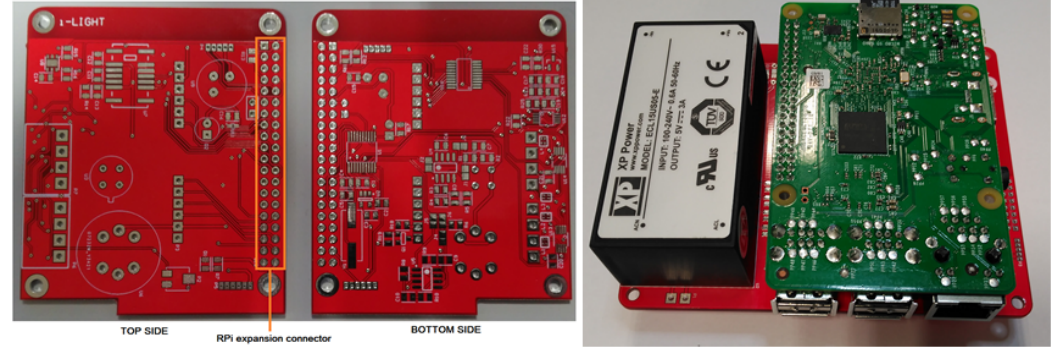
Figure 5. Printed circuit board and processing unit.